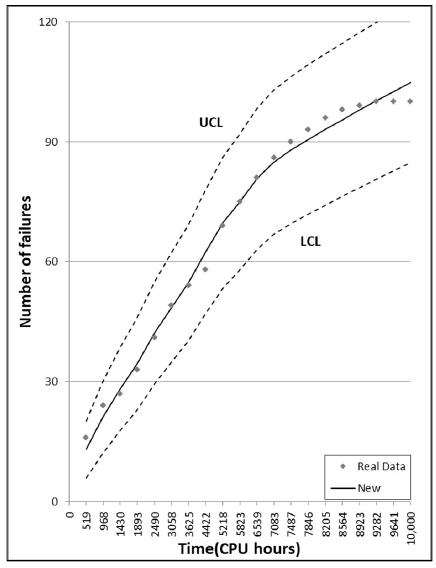
Figure 7. 95% confidence limits of the newly proposed model for DS3.